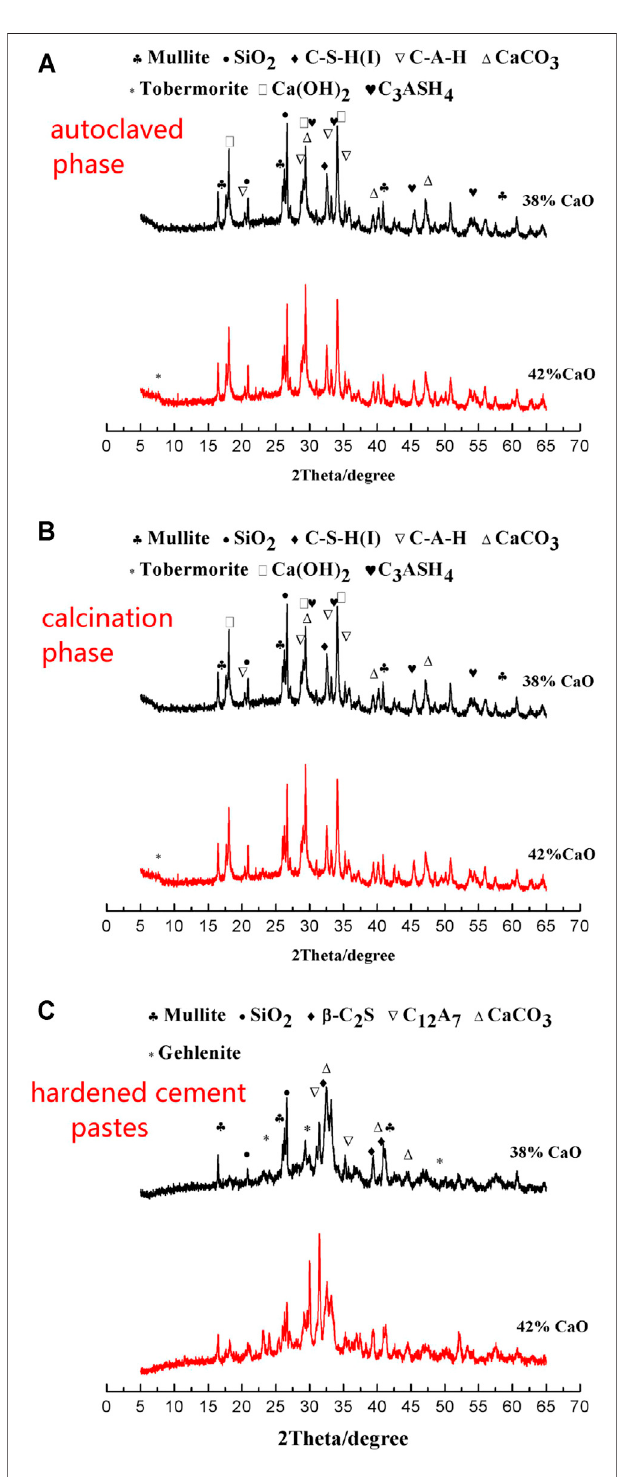
FIGURE 1 | X-ray diffraction patterns of the two specimens (B and C) : (A) autoclaved, (B) after calcination, and (C) hardened cement pastes.